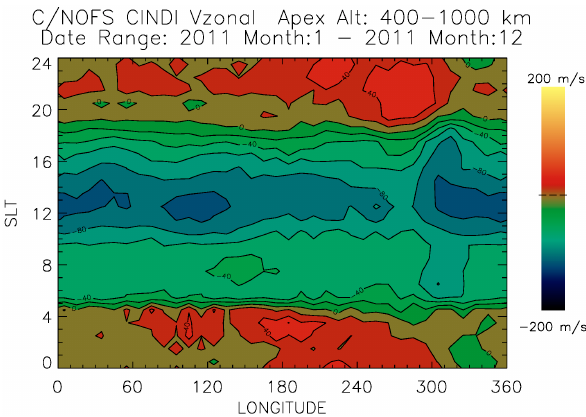
440 Figure 4. Contour plot of CINDI zonal velocities versus SLT (hours) and longitude 441 for the year 2011. All available data in the 400–1000 km apex altitude range was 442 Fig. 4. Contour plot of CINDI zonal velocities versus SLT (hours) and longitude for the year 2011. All available data in the 400– 1000km apex altitude range were used.